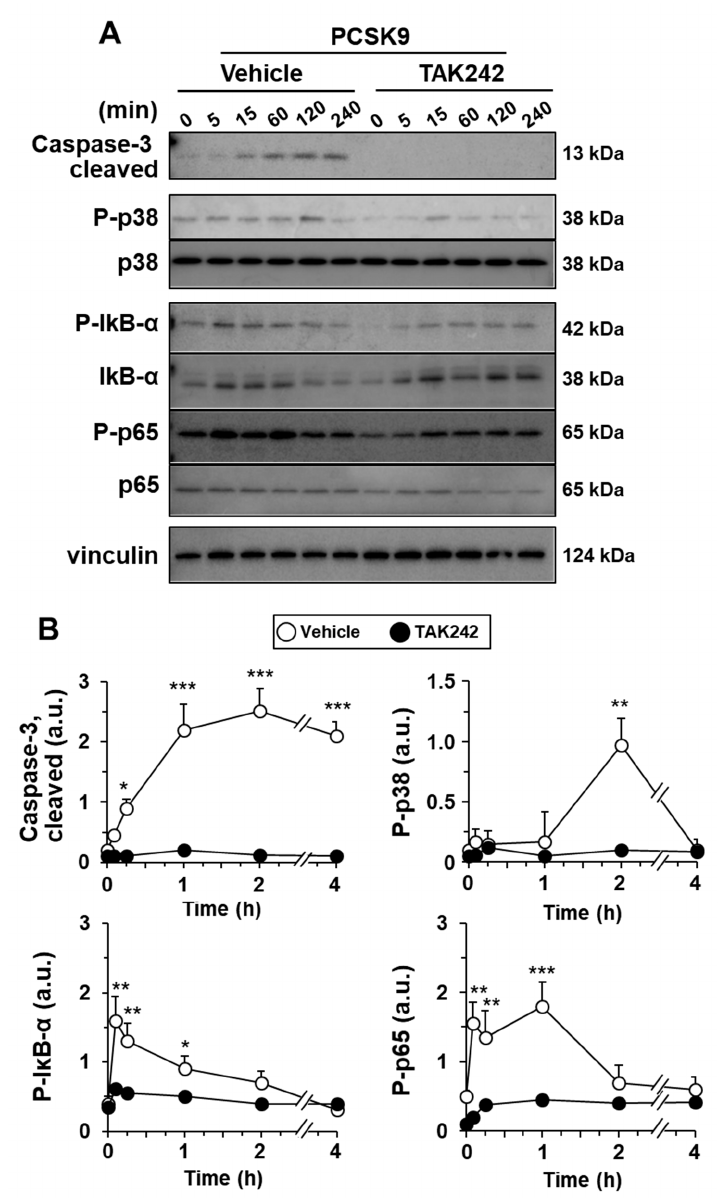
Figure 5. PCSK9 activates NF- κ B, p38 MAPK, and caspase-3 processing in human macrophages. Cells were pre-treated for 30 min with vehicle or 1 µM of the TLR4 inhibitor TAK242 before incuba-